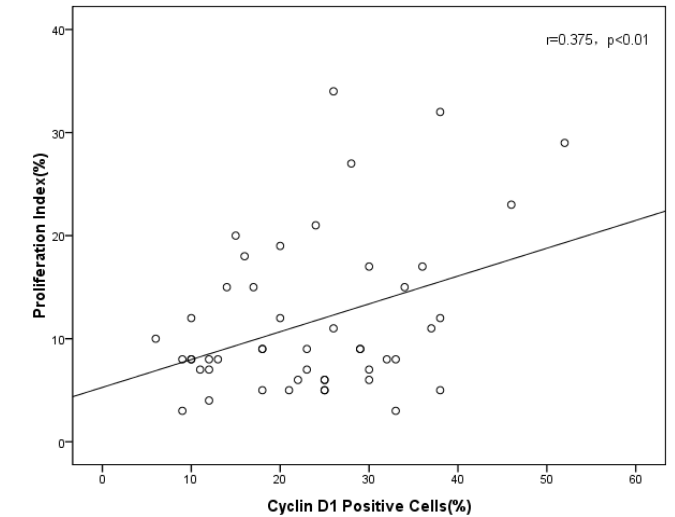
Figure 4. Correlation of tumor cell proliferation index with cyclin D1 positive rates ( r = 0.375, p < 0.01).